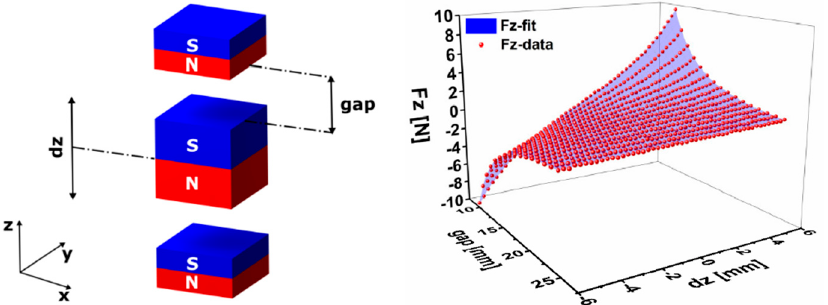
Figure 2. Vertical magnet configuration considered in the static magnetic simulation ( left ), together with the two-variable fitting function for the attractive force component F Z ( right